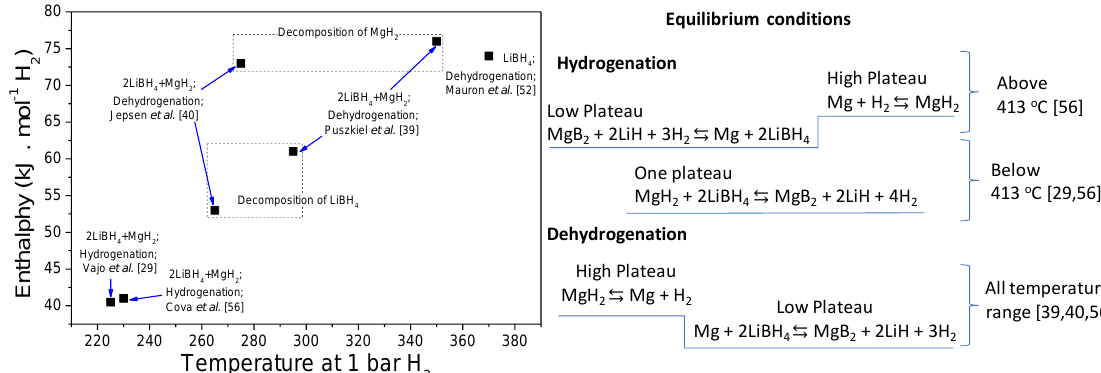
Figure 5. Thermodynamics of the 2LiBH 4 :MgH 2 hydride system: reaction enthalpy as a function of the desorption temperature at 1 bar H 2 and reaction pathways in equilibrium conditions.